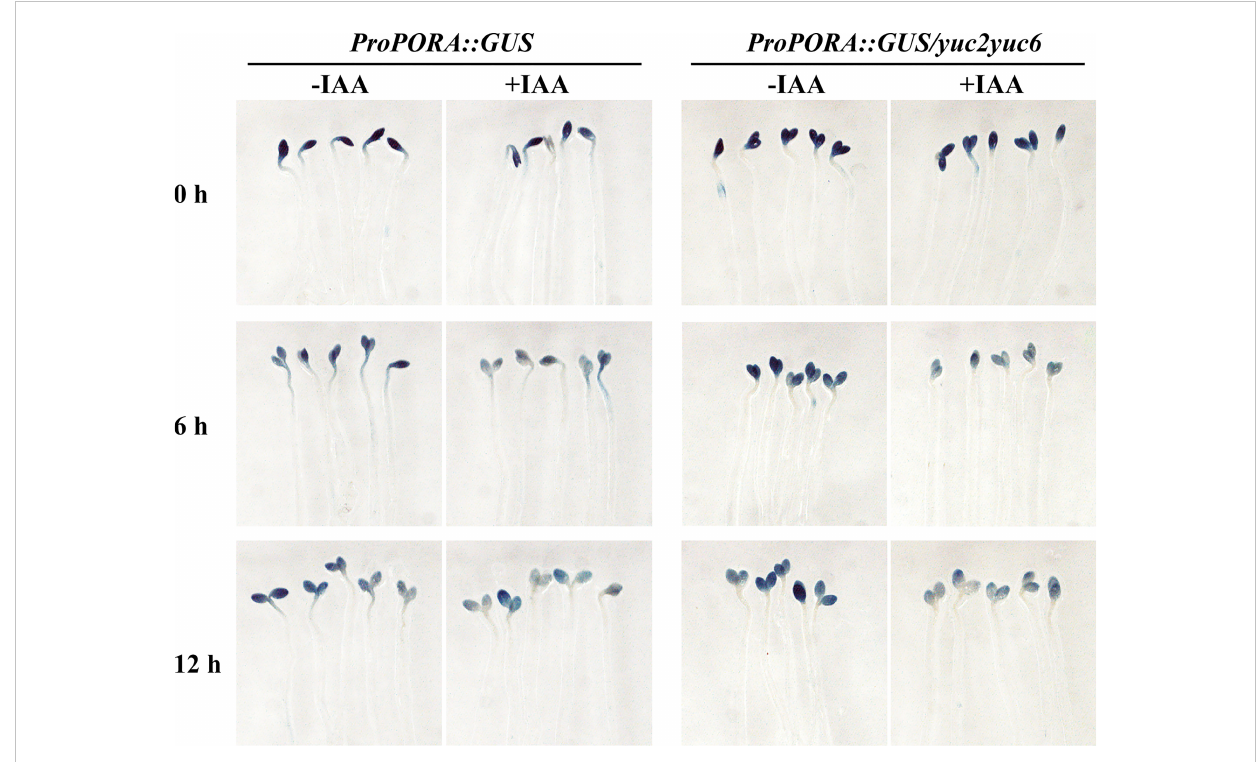
FIGURE 7 Auxin suppresses the expression of GUS driven by PORA